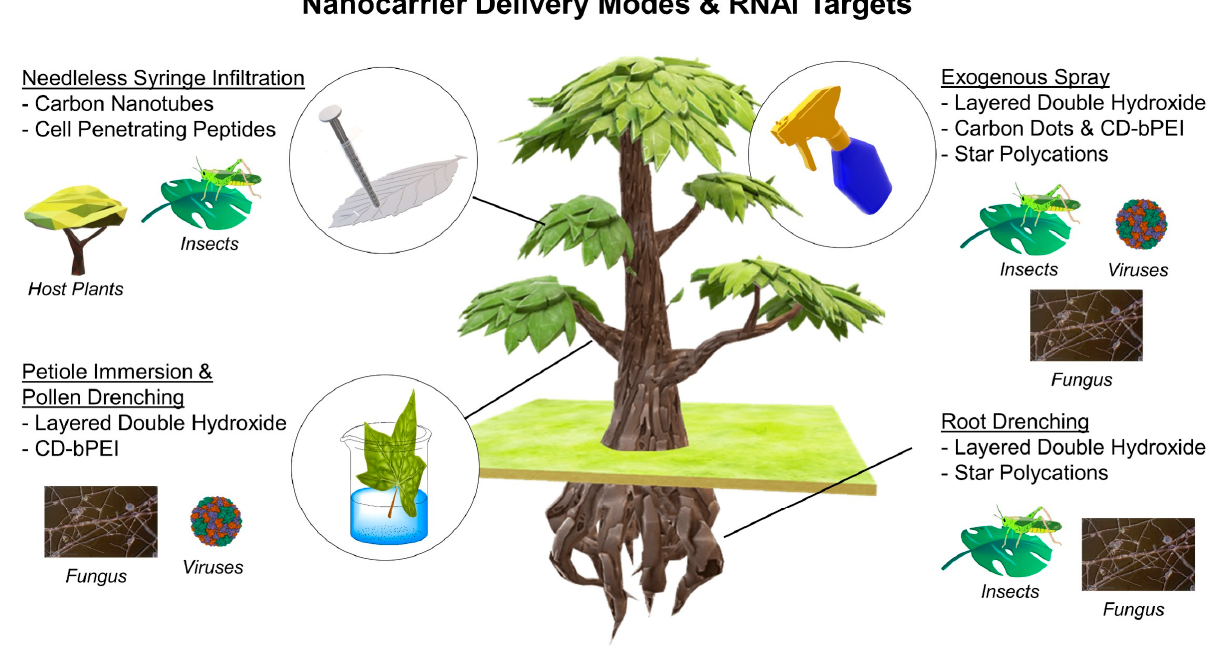
Figure 1. Overview of the recent nanotechnologies for RNAi delivery in plants, its delivery modes and the RNAi targets. The Viruses image is taken from Protein Data Bank (PDBID = 1F15) and the Fusarium solani (the Fungus image) was taken by Josef Reischig under CC BY SA 3.0 licensed to Wikimedia Czech Republic. Color image available online.